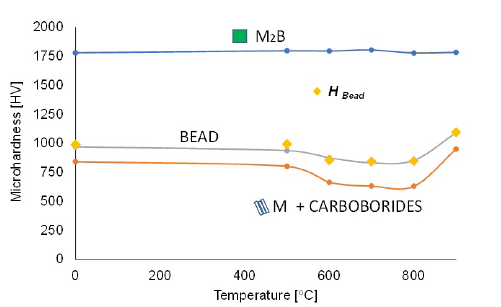
Figure 8. Microhardness of the phases based on the PWHT temperature.